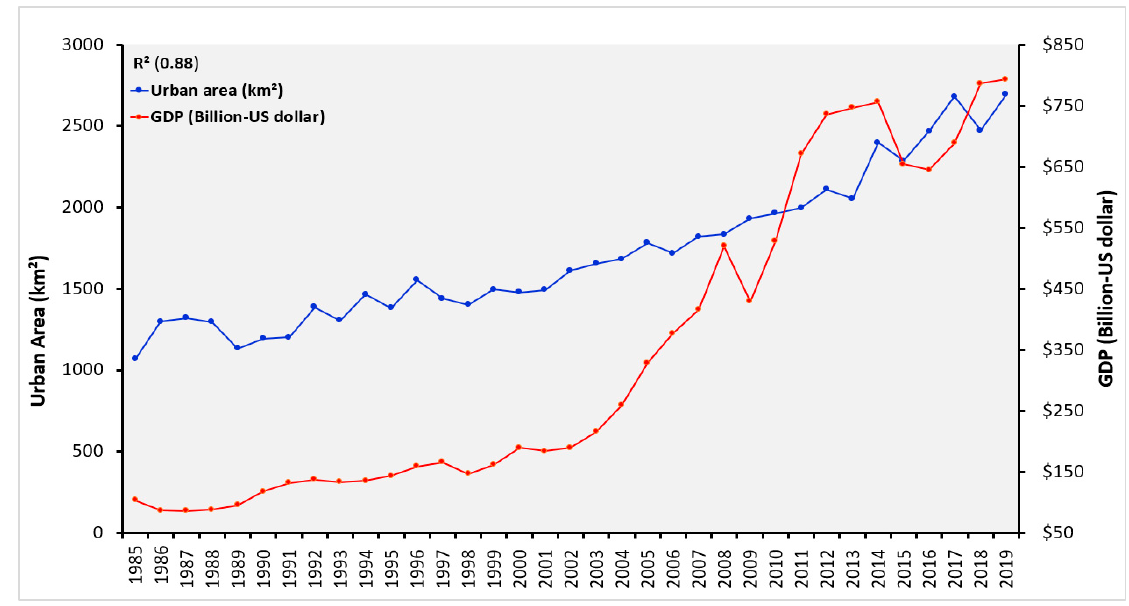
Figure 14. The urban area of the capitals and the GDP of the country.